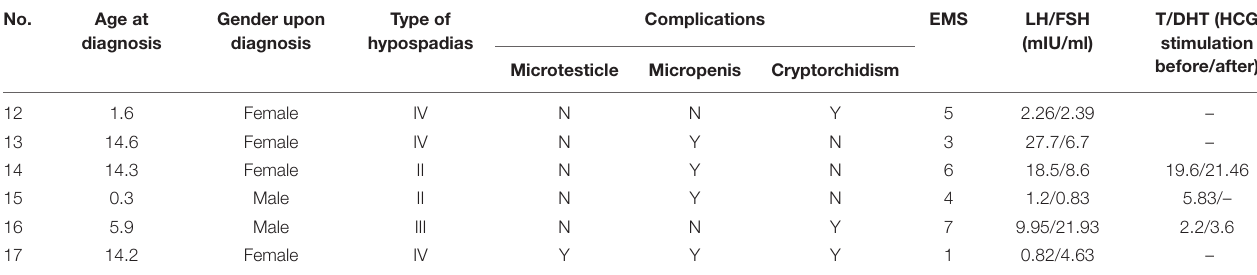
TABLE 4 | The clinical features of 6 patients carrying AR mutations.